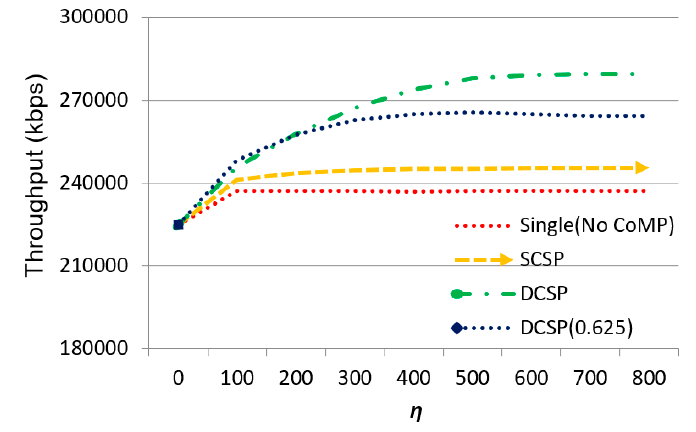
Figure 6. The effect of η on throughput.